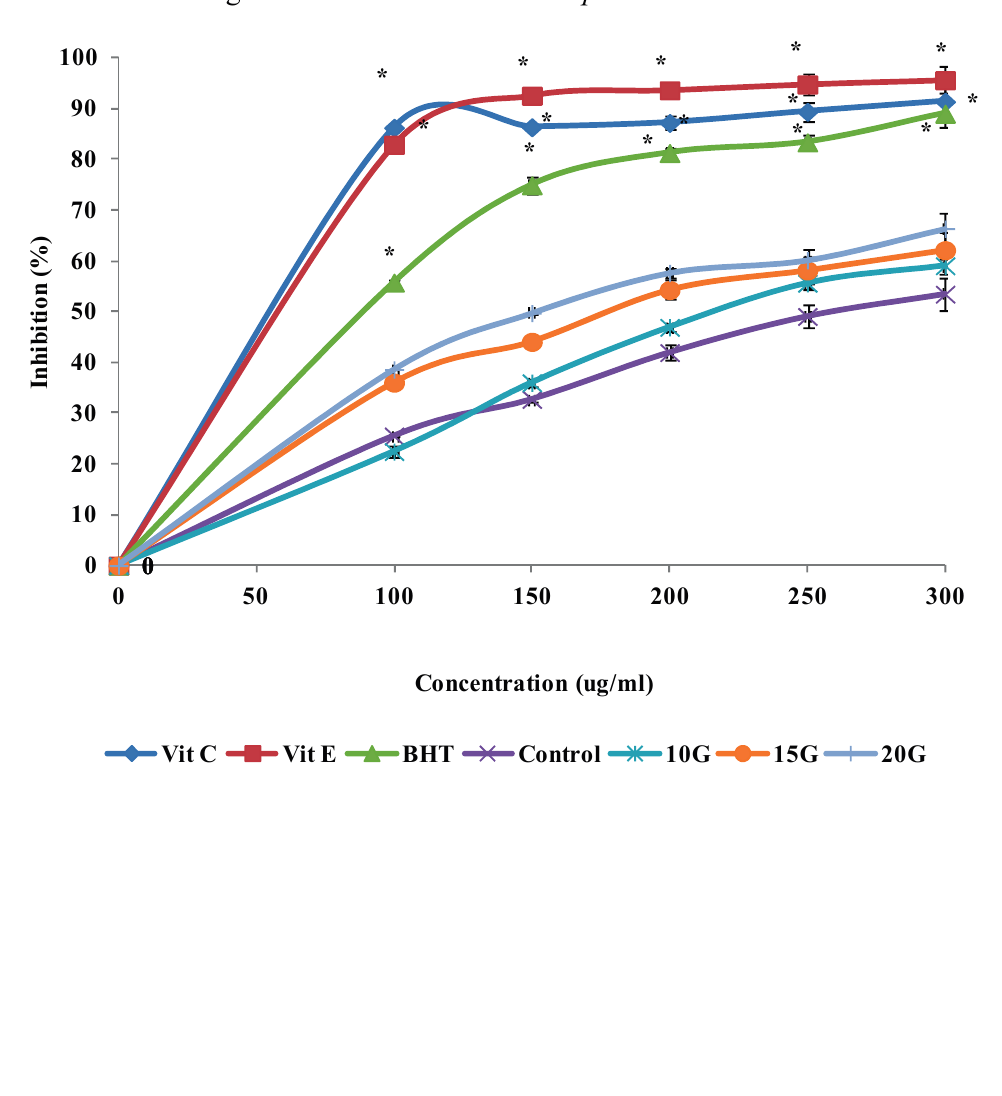
Figure 2. Effect of gamma irradiation on the free radical scavenging activity of methanolic extracts and standards at different concentrations. Values are means ± SE. Each value represents the mean of three replications. * Significance different from Control group at the same concentration. Significance was determined at p <